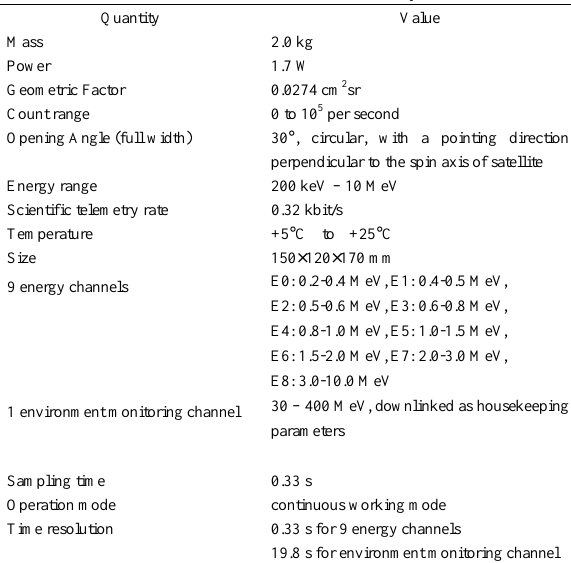
Table 2. Instrument data summary of HEED. Table 2 Instrument data summary of HEED